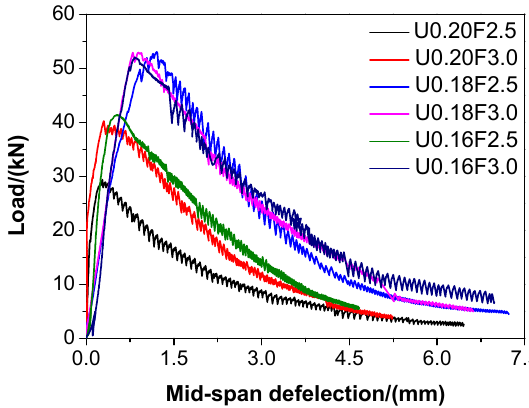
Figure 6. Load-deflection relationships of the UHPCs.